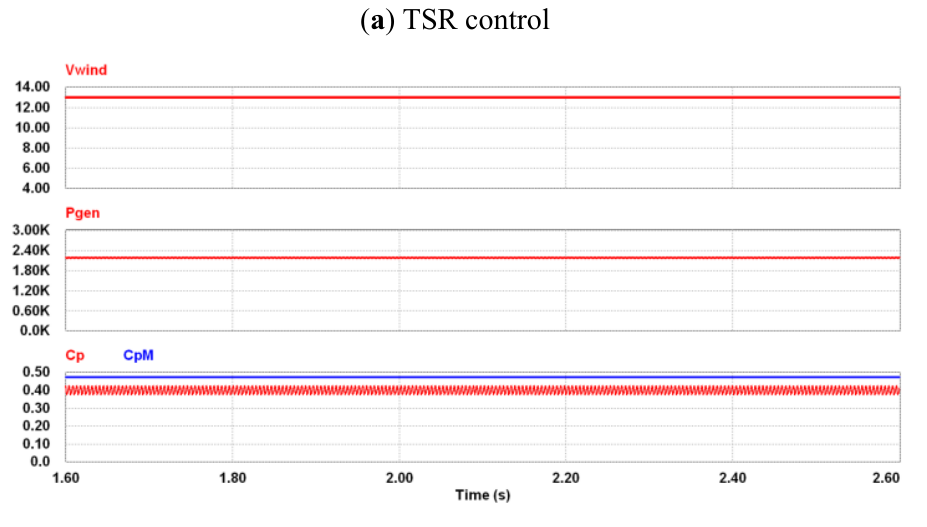
Figure 11. Comparison of steady state performance with each MPPT